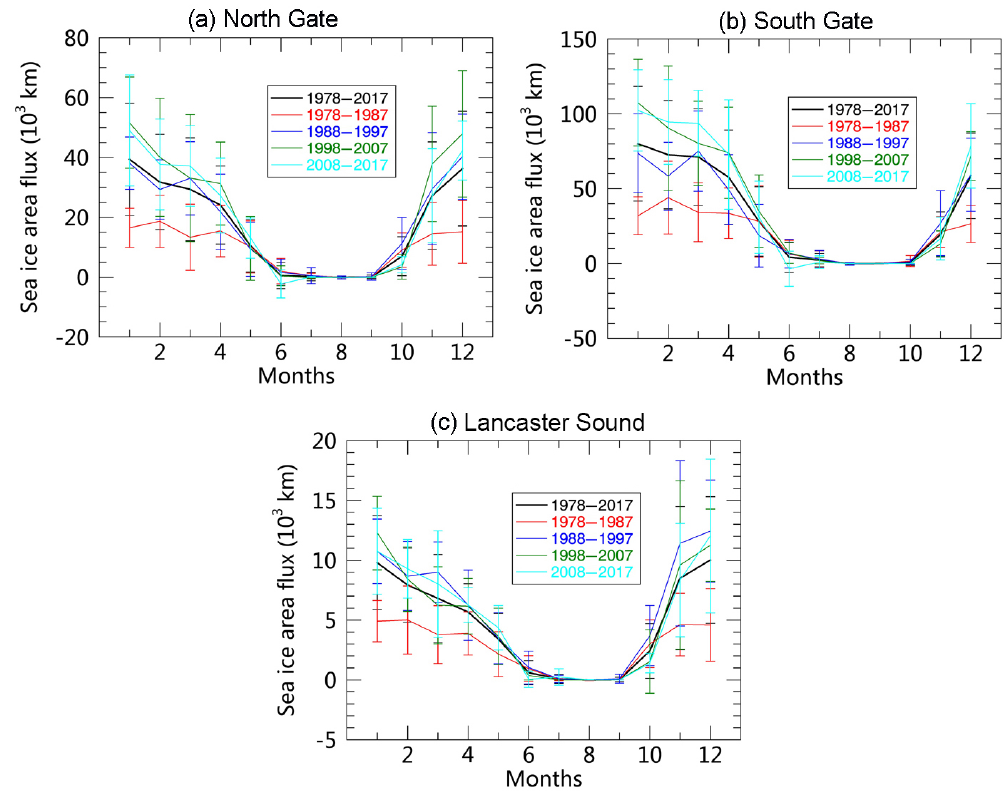
Figure 11. Monthly mean sea ice area export in (a) the northern gate, (b) the southern gate, and (c) Lancaster Sound. Both the climatology (1978–1979 to 2016–2017) and decadal mean fields are given in the